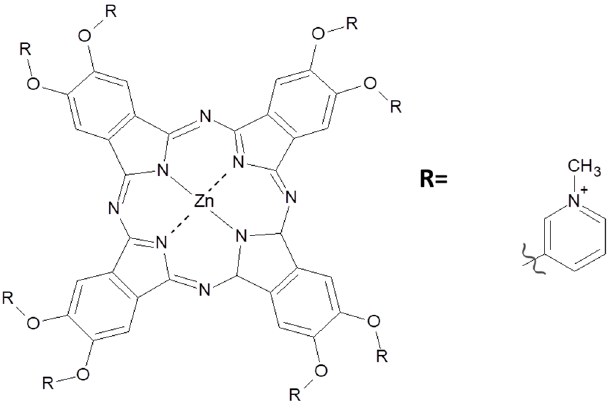
Figure 21. Cationic zinc phthalocyanines used to improve SWCNTs solubilization in water [7].